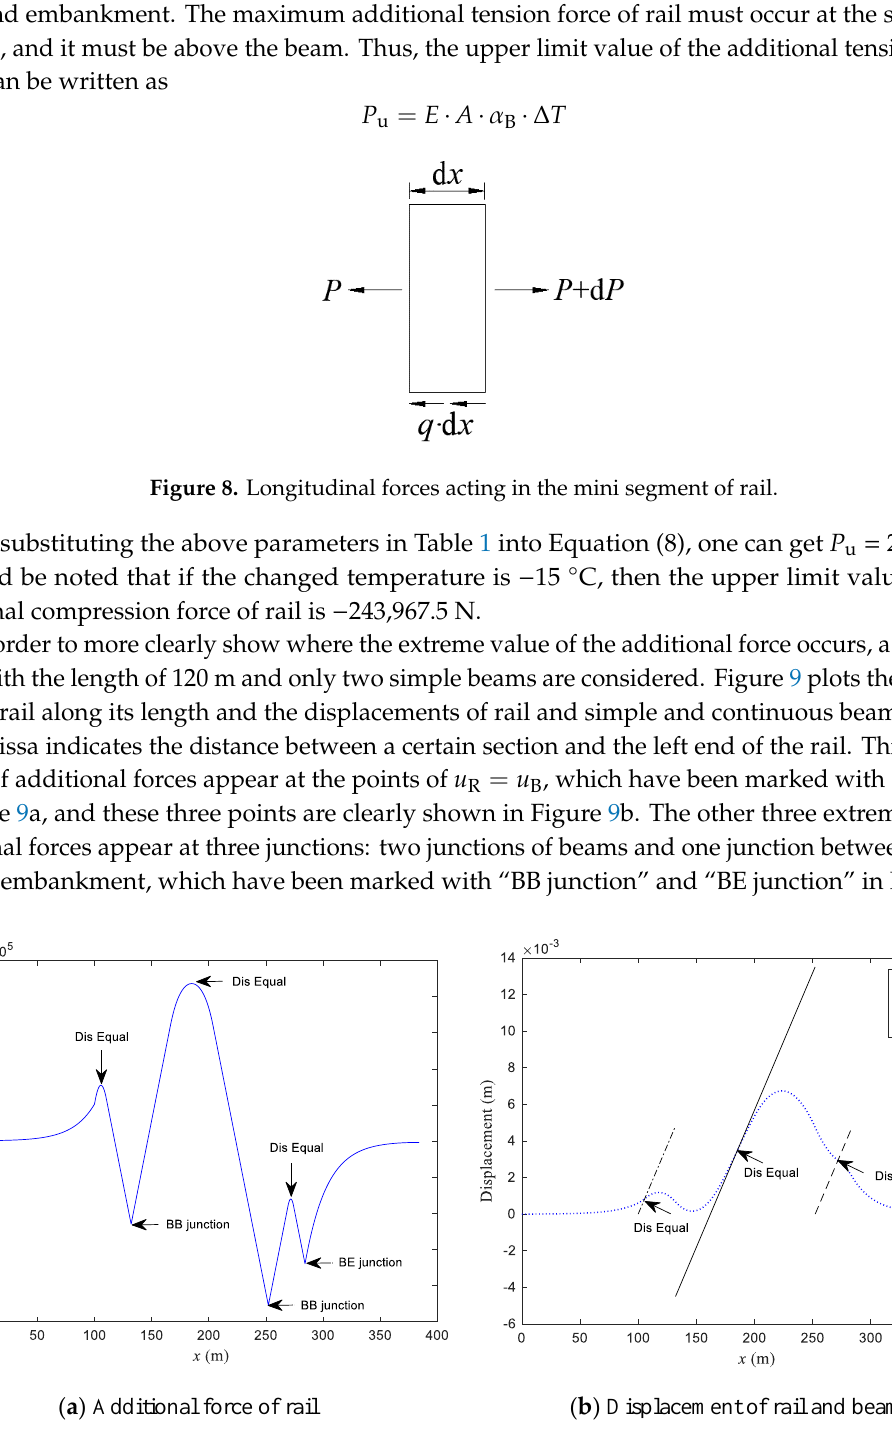
Figure 9. Distribution of the additional force and displacements of rail and beam.